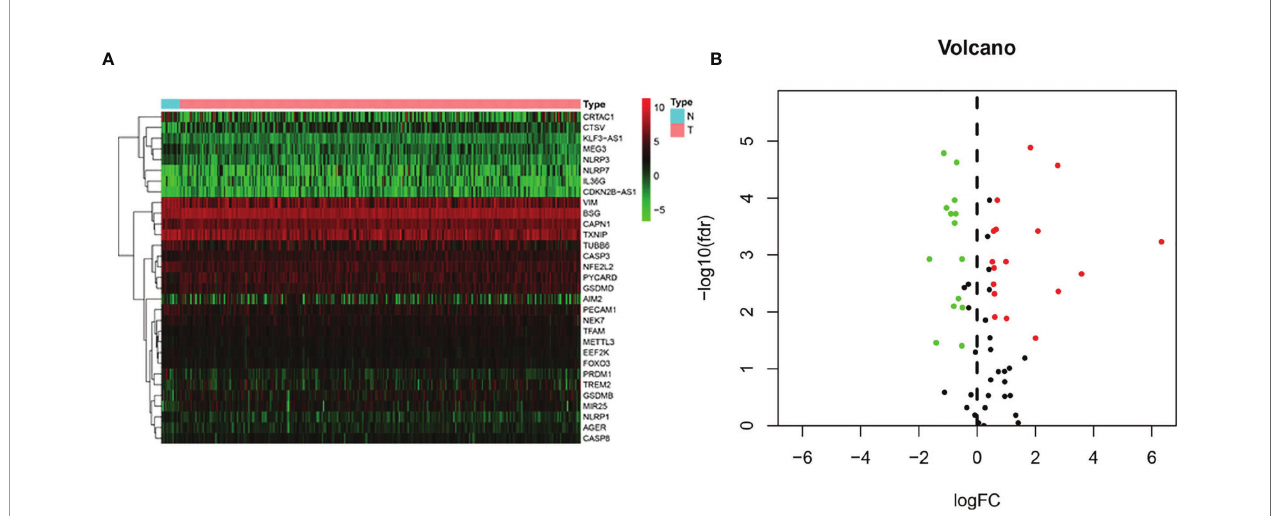
FIGURE 2 | DEPRGs in BLCA versus non-cancerous samples. (A) Heatmap and (B) a volcano